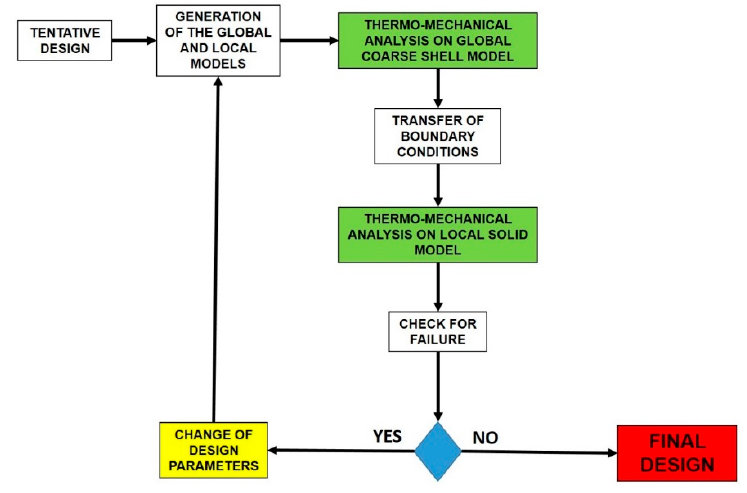
Figure 3. Thermo-structural design loop.